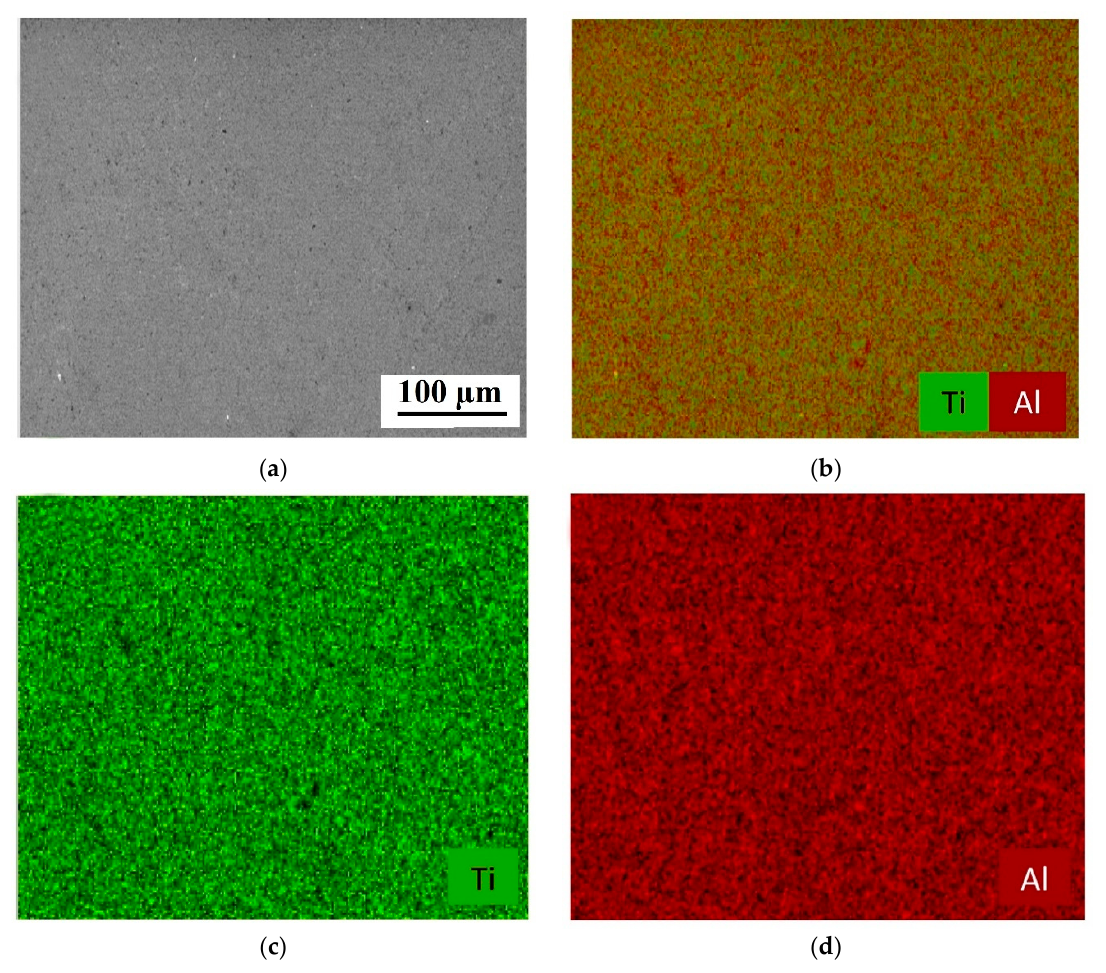
Figure 2. SEM micrographs of Al 2 O 3 ‐ TiC composites: ( a ) polished surface of the sample with 30 vol.% TiC; ( b ) polished surface of the sample with 40 vol.% TiC; ( c ) fractured surface of the sample with 30 vol.%; ( d ) fractured surface of the sample with 40 vol.%. In the figure, alumina is dark, and TiC is light.